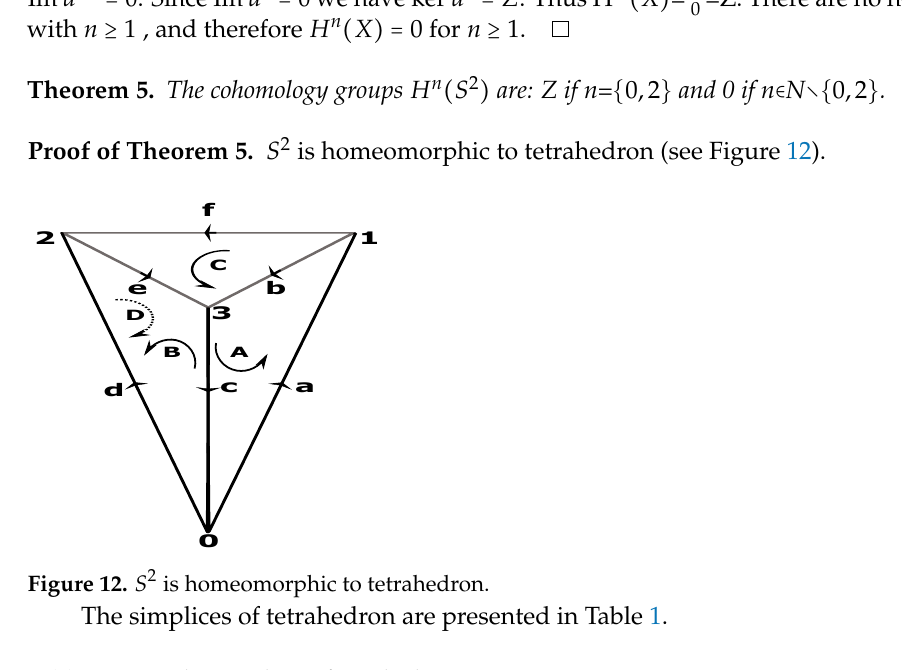
Table 1. 0, 1 and 2-simplices of